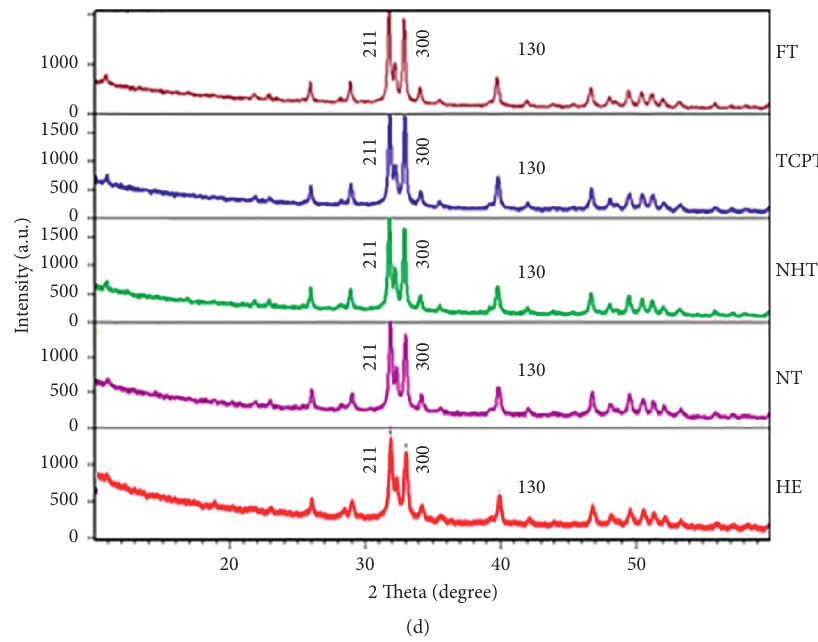
Figure 2: (a) Mean, standard deviation of baseline hardness ( H B ), and hardness after artificial formation of demineralization ( H D ). Hardness after application of pH-cycling ( H R ), (b) hardness difference determined between after application of pH-cycling and after artificial formation of demineralization ( H diff � H R − H D ), percentage of hardness recovery (% HR), (c) remineralization potential (RP), percentage of remineralization potential (% RP), and (d) XRD patterns of each group treated with nanohydroxapatite toothpaste (NHT), tricalcium phosphate toothpaste (TCPT), and fluoride toothpaste (FT) in comparison to no-treatment group (NT) and healthy enamel (HE). Table 3: An analysis of variance (ANOVA) of baseline hardness ( H B ), hardness after artificial formation of demineralization ( H D ), hardness after application of pH-cycling and remineralization process ( H R ), hardness difference determined between after application of pH-cycling and remineralization process and after artificial formation demineralization ( H diff � H R − H D ), and percentage of hardness recovery (%